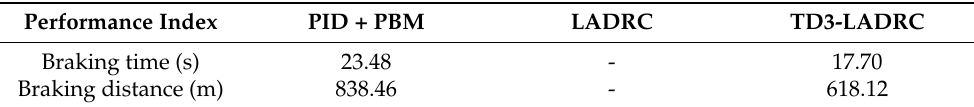
Figure 10. ( a ) Extended state of TD3-LADRC; ( b ) controller bandwidth ω c ; ( c ) controller bandwidth ω o . Table 9. AABS performance